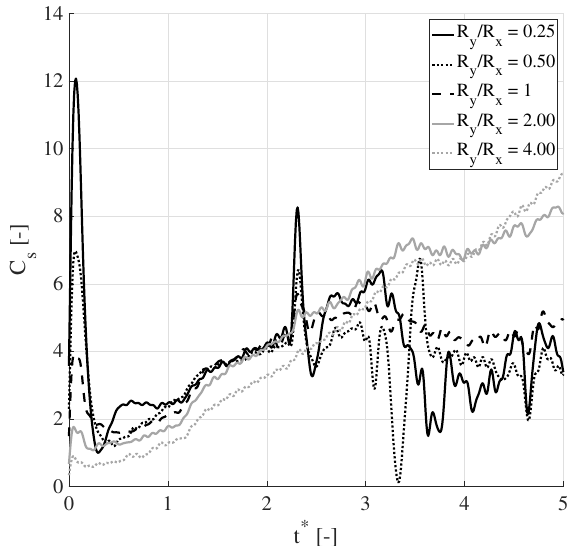
Figure 17. Slamming coefficient as a function of the ellipse aspect ratio. Solid black line represents aspect ratio of 0.25, dotted black line 0.5, dashed black line the circular obstacle with R y / R x = 1.0, solid light gray line the aspect ratio of 2.0, and dotted light gray line the largest aspect ratio of